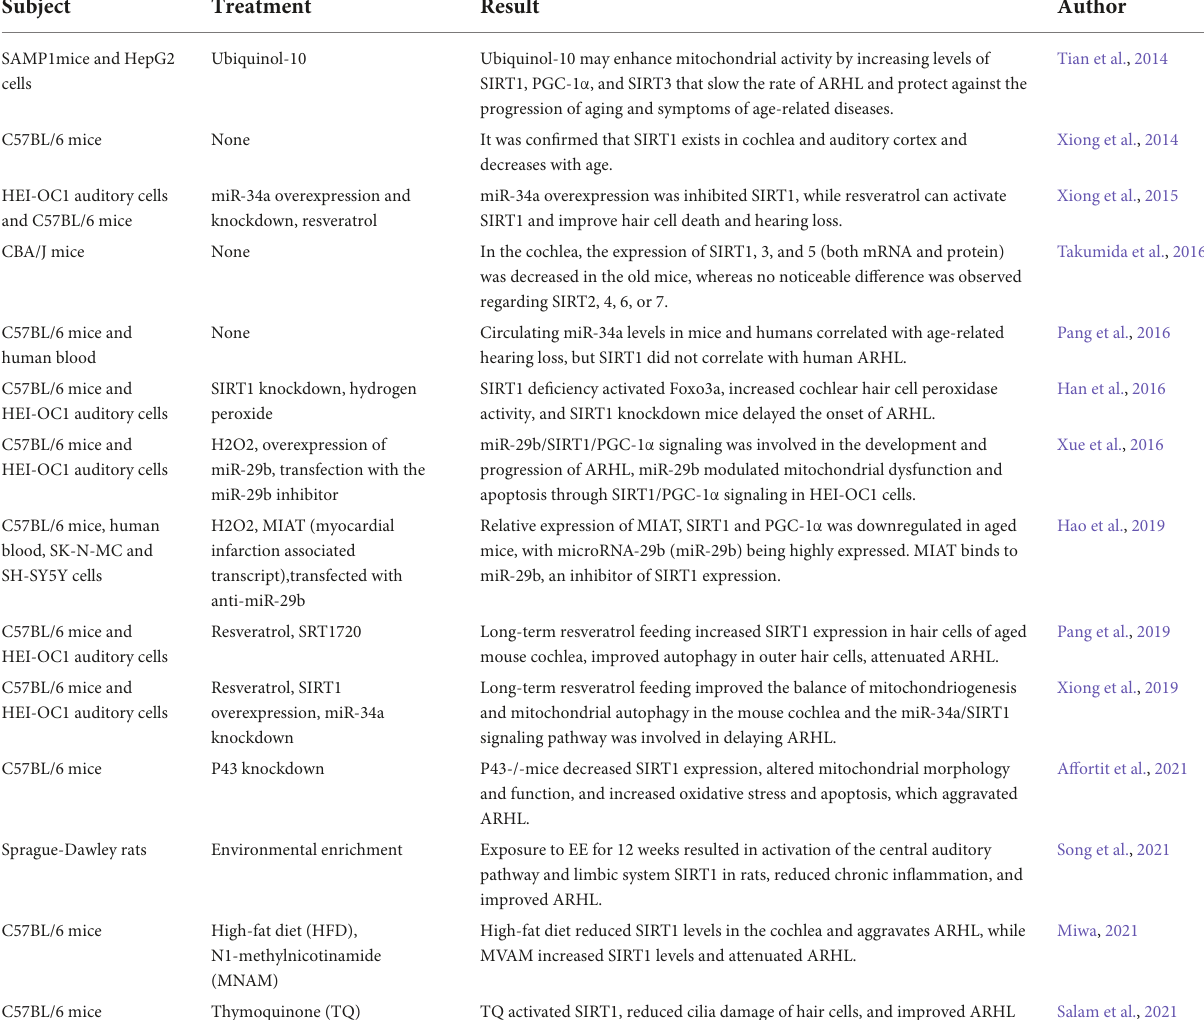
TABLE 1 SIRT1 and ARHL related